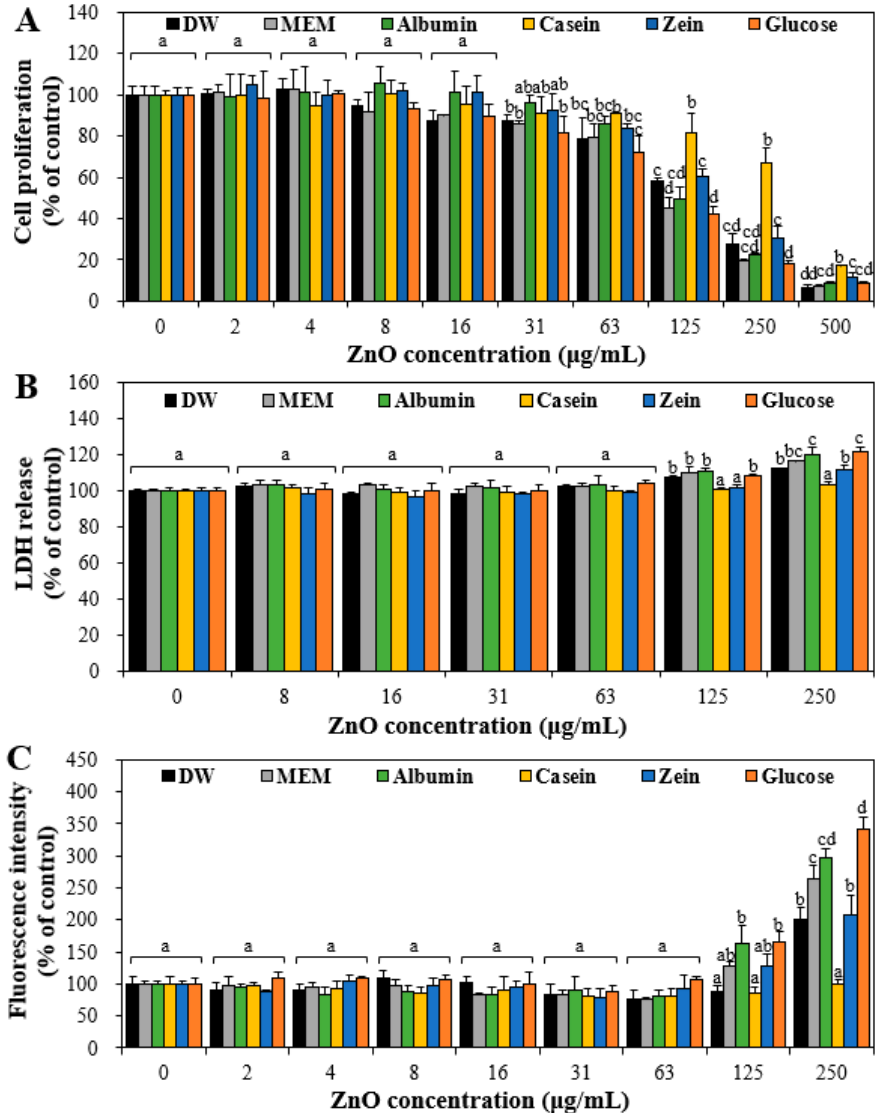
Figure 5. Effects of interactions between ZnO NPs and food proteins or glucose on ( A ) cell proliferation, ( B ) lactate dehy- ation, ( B ) lactate dehydrogenase (LDH) release, and ( C ) reactive oxygen species (ROS) drogenase (LDH) release, and ( C ) reactive oxygen species (ROS) generation in Caco-2 cells after 24 h. Cells without ZnO NPs were used as controls. Different lowercase letters (a,b,c,d) indicate significant differences among control and ZnO NPs interacted with DW, MEM, food proteins, or glucose ( p < 0.05).